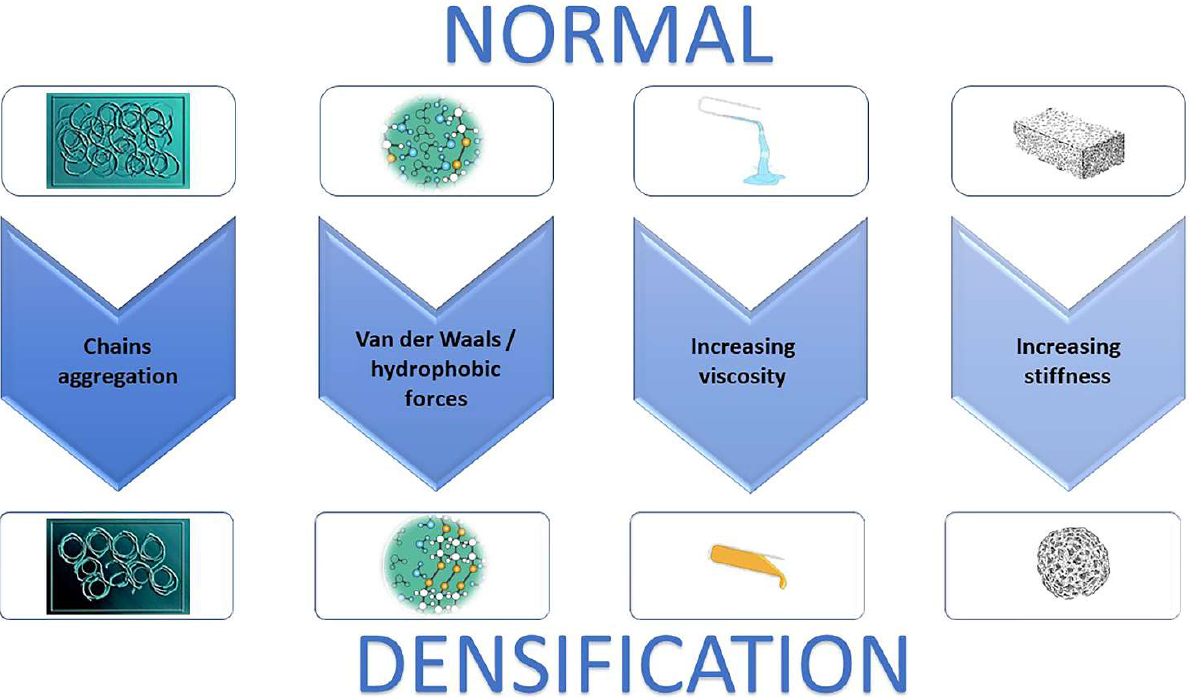
Figure 2. The biological process of densification development. Hyaluronan increases in concentration, then aggregates, releasing water. This process generates a macromolecular structure that increase the viscosity of the extracellular matrix consequently increasing tissue stiffness.